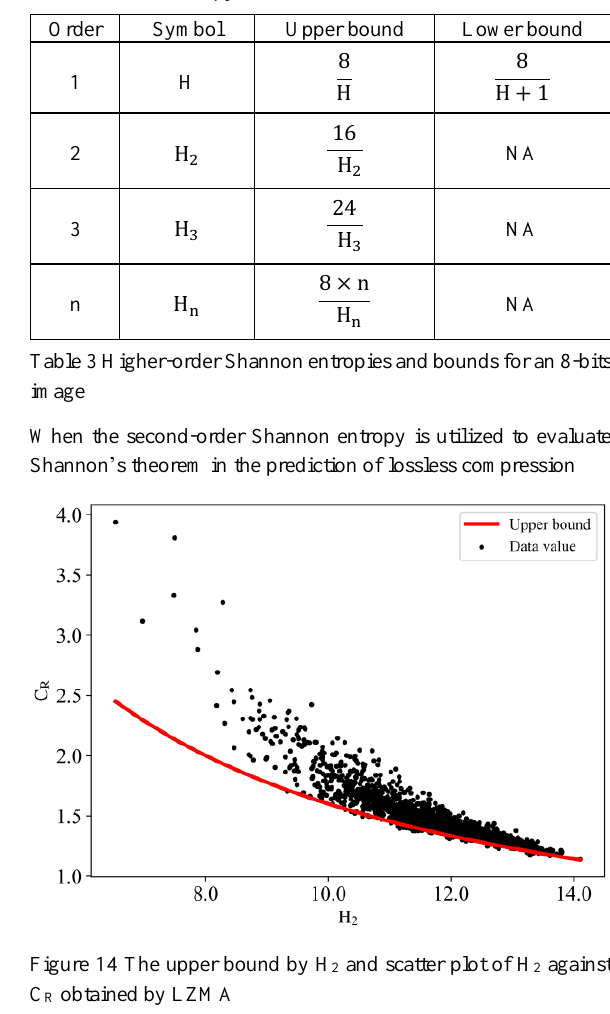
Table 2 Occurrence probabilities of gray-level pairs for the image shown in Figure 13 With the definition of higher-order Shannon entropies, corresponding upper bounds are shown in Table 3 where NA means “unavailable”. Higher-order Shannon entropies consider a few structures of pixels. Thus, they are more powerful than first- order Shannon entropy.